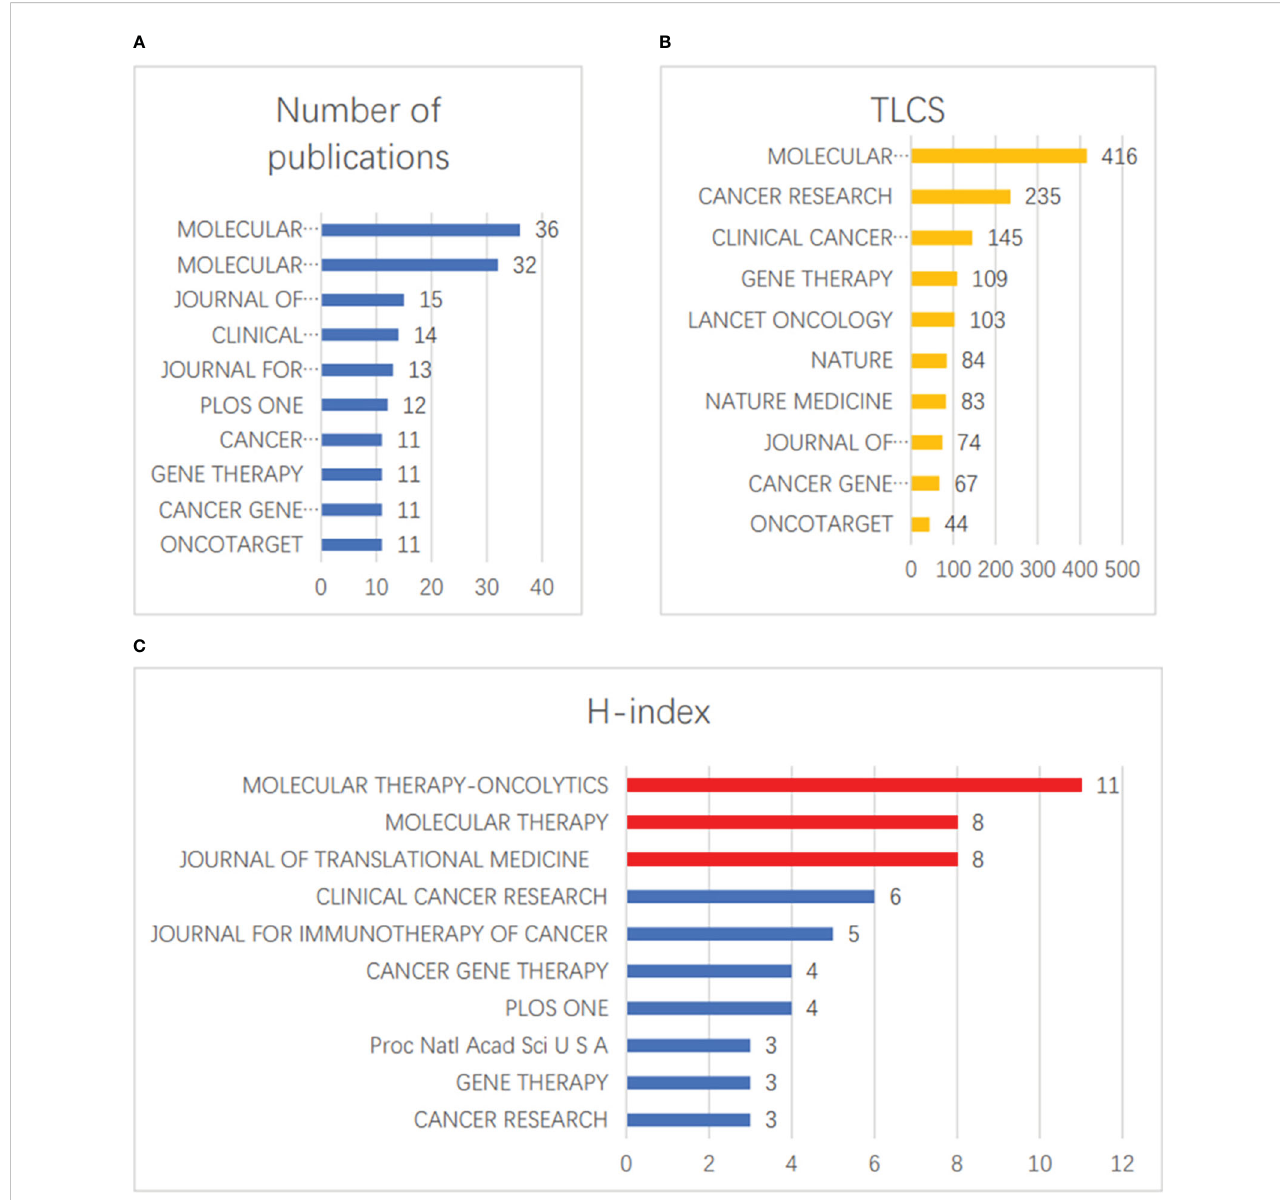
FIGURE 5 Published journals. (A) The top 10 journals with the greatest numbers of publications. (B) The top 10 journals with the most LCS. (C) The top 10 journals with the greatest H-index